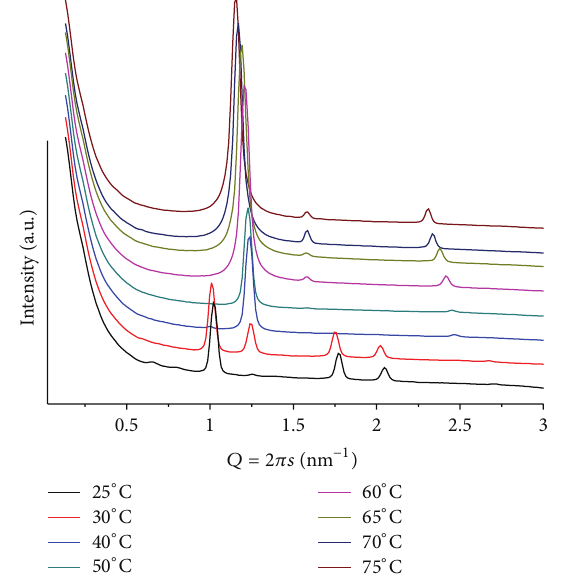
Figure 9: SAXS patterns at different temperatures for POPE/ ANHQ, mr = 100 and pH = 4